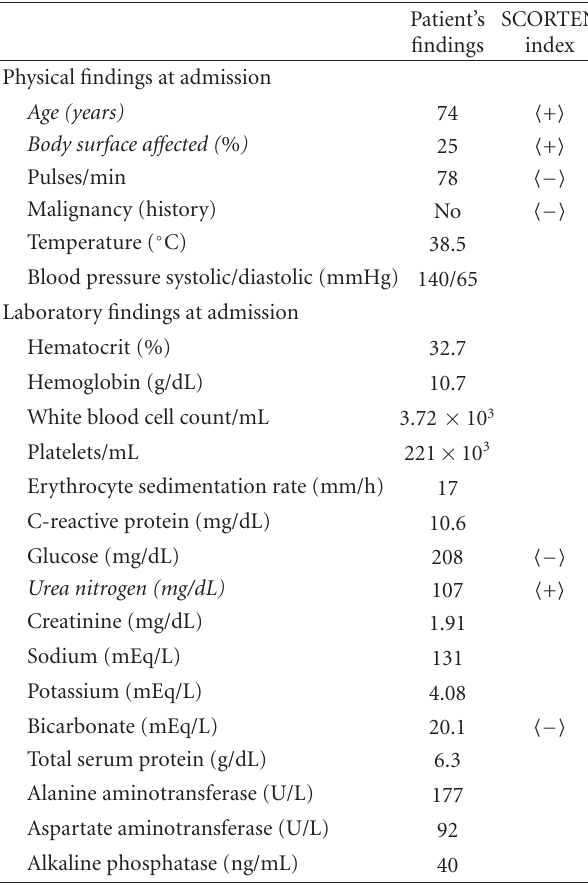
Table 1: Core physical and laboratory data of the patient at admission. Parameters included in the calculation of the SCORTEN index are indicated in bold; parameters adding to SCORTEN in the present case are indicated in italics (SCORTEN index = 3).